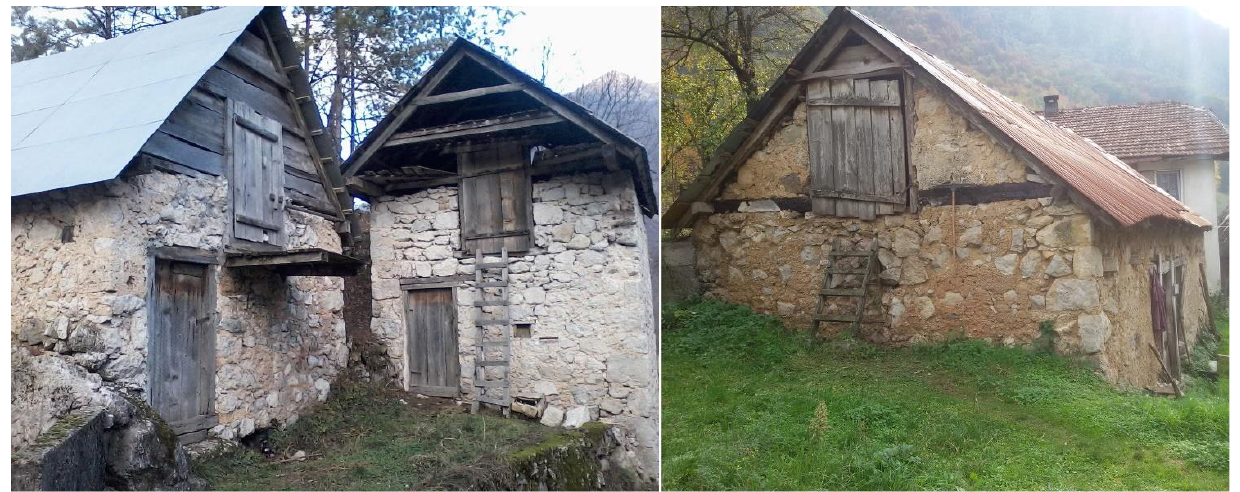
Figure 4. Multiple-story house in the hamlet Nuhići. (Source: Author)